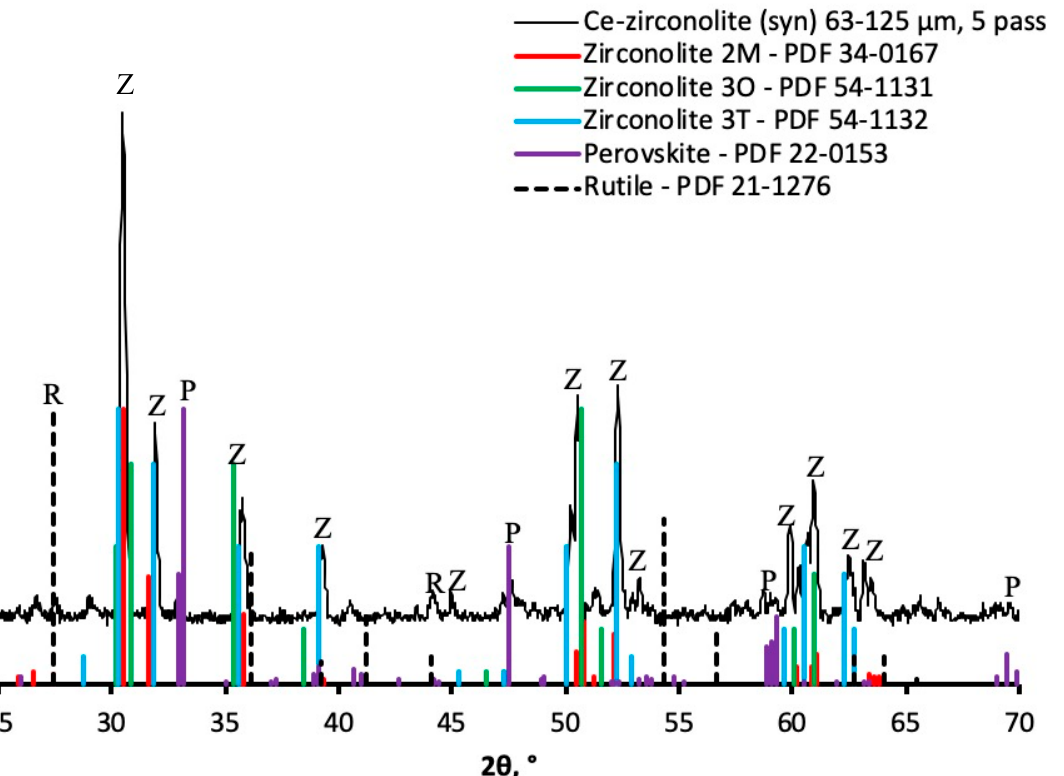
Figure 1. X-ray di ff raction (XRD) pattern of the zirconolite material with relevant PDF Figure 1. X-ray diffraction (XRD) pattern of the zirconolite material with relevant PDF references.